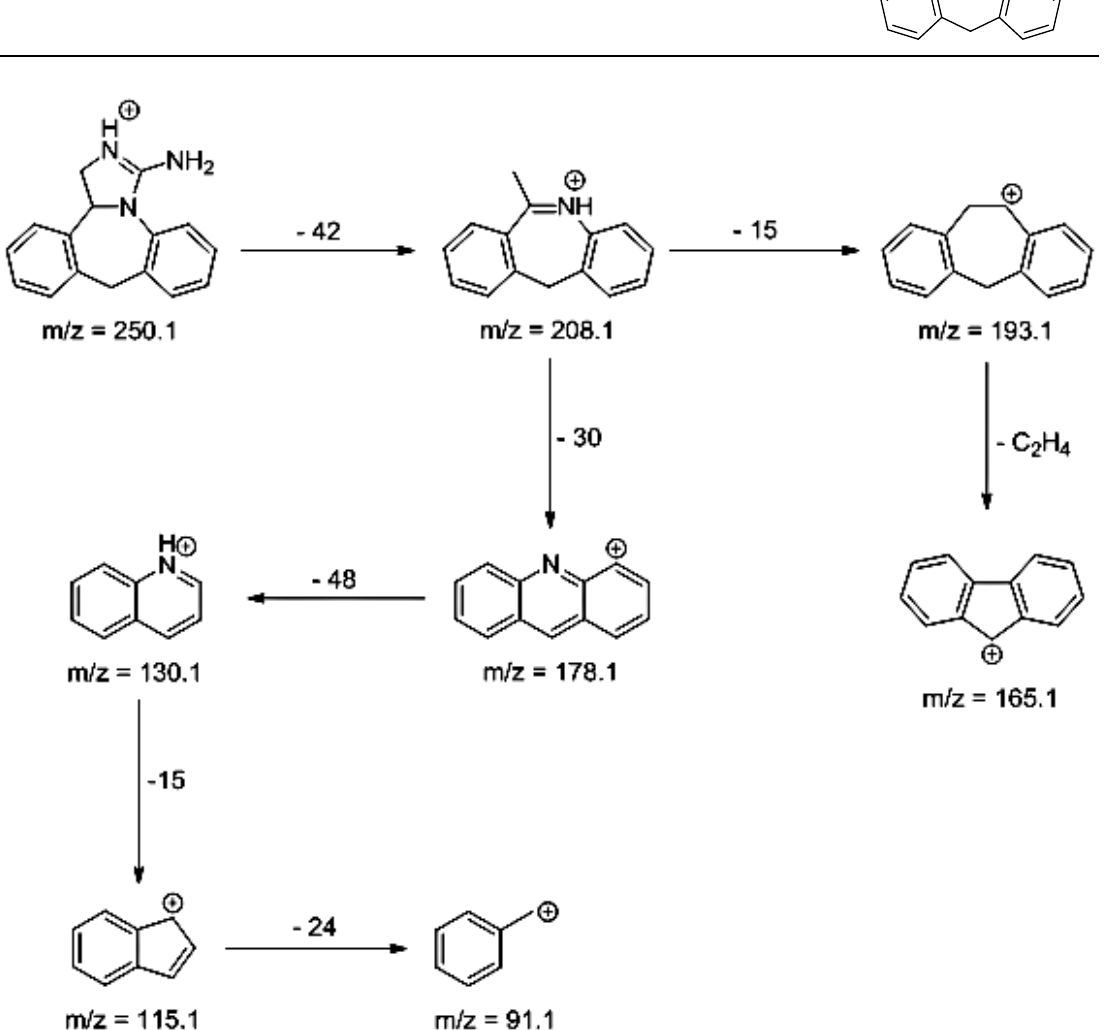
Figure 7. Proposed fragmentation pattern of epinastine (EPI).